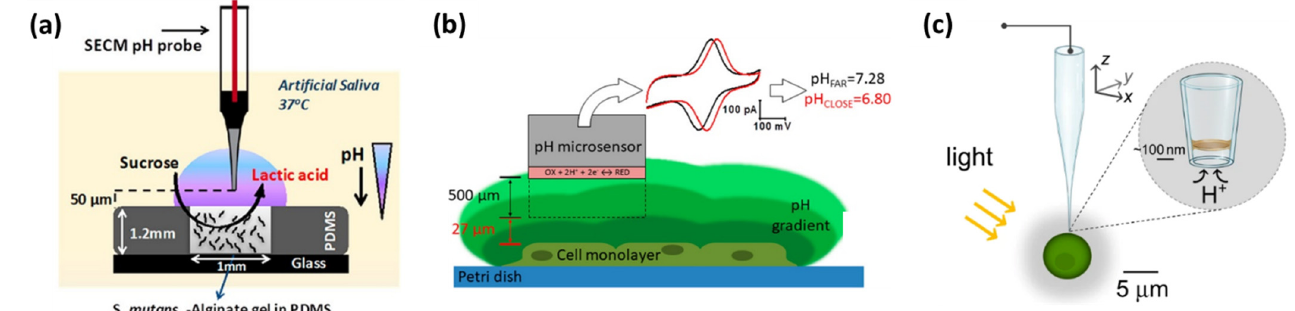
Figure 6. ( a ) Application of a potentiometric pH sensor to obtain a 3D image of pH distribution in the S. mutans biofilm. Reprinted from ref. [48]. Copyright (2017) with permission from American Chemical Society. ( b ) Schematic representation of the voltametric pH microprobe for measuring pH gradients in the extracellular space of mammalian cells. Adapted from ref. [37]. Copyright (2018) with permission from the American Chemical Society. ( c ) Scheme showing the pH measurement of the phycosphere of marine green algae Chlamydomonas concordia RCC1 and the effect of light/dark. Adapted from ref. [88] under CC-BY 4.0 license.